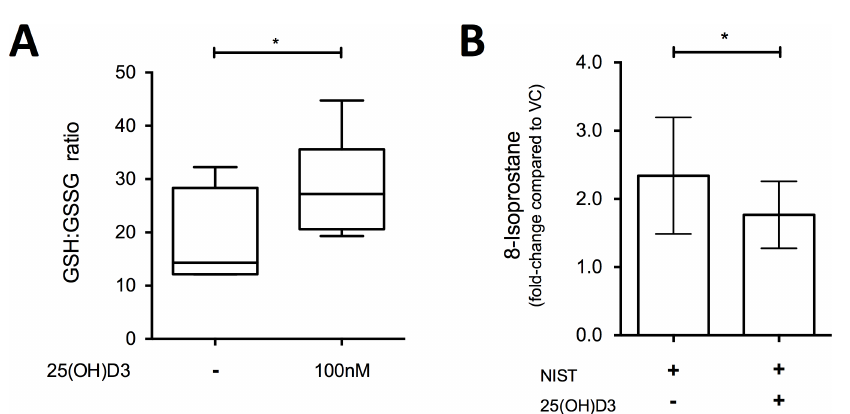
Fig 5. Effect of 25(OH)D3 on antioxidant responses in primary HBEC cultures. (A) Ratio of reduced (GSH) to oxidised (GSSG) glutathione in 24 hour cultures of HBECs treated with/without 100nM 25(OH)D3; n = 6. (B) Fold- increase in 8-isoprostane levels in culture supernatants from primary HBECs cultured with 50μg/ml NIST with/ without 100nM 25(OH)D3 for 24 hours, compared to VC control cultures; ratio paired t-test, n = 8. Statistical significance as follows: (cid:3) , p (cid:20) 0.05.